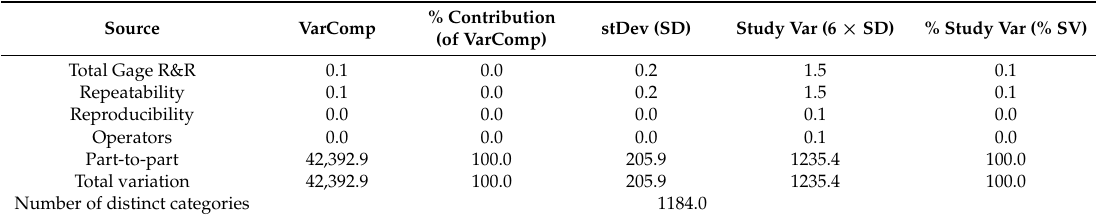
Table 5. Condition 2 Gage R&R for the resonant frequency ( f r )